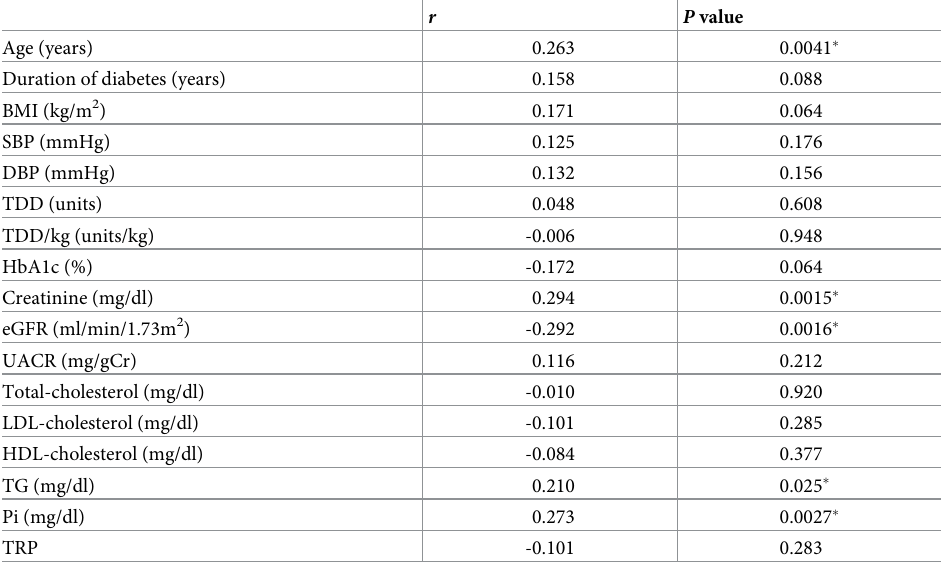
The Pearson’s correlation coefficient was used. � Statistically significant ( P < 0.05) FGF23, fibroblast growth factor 23; BMI, body mass index; SBP, systolic blood pressure; DBP, diastolic blood pressure; TDD, total daily dose of insulin; TDD/kg, body weight-adjusted TDD; HbA1c, hemoglobin A1c; eGFR, estimated glomerular filtration rate; UACR, urinary albumin creatinine ratio; TG, triglycerides; Pi, inorganic phosphate; TRP, tubular reabsorption of